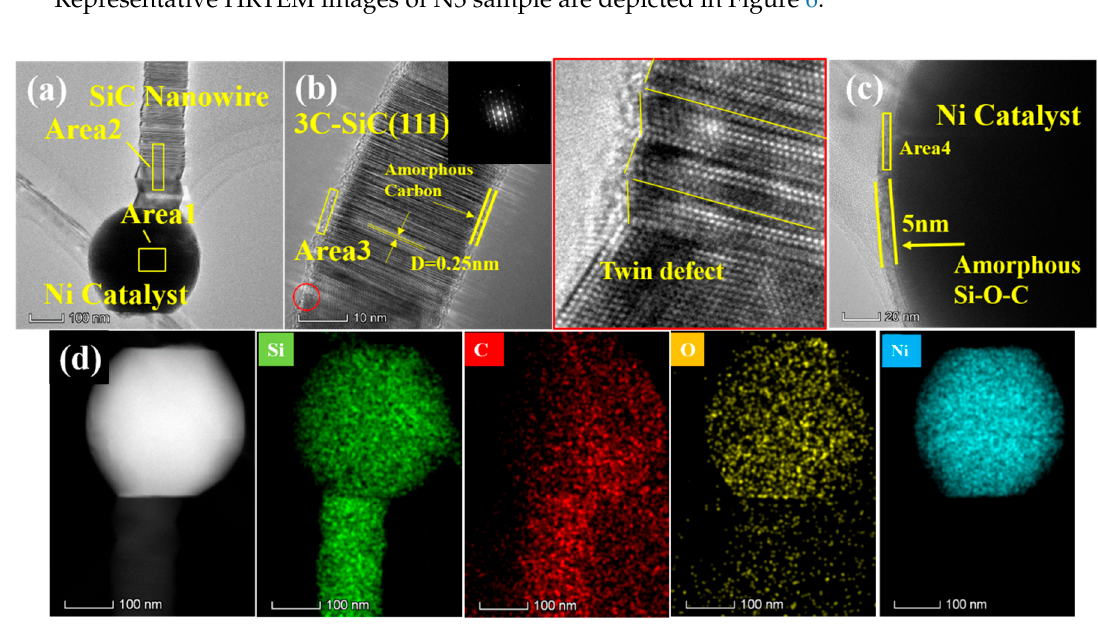
Figure 6. ( a ) TEM image of N3 sample; ( b ) HRTEM image and SAED pattern of nanowire; ( c ) HRTEM image of catalyst; ( d ) EDS mapping of N3 sample.